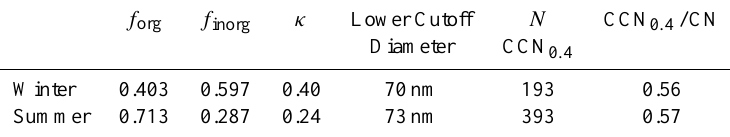
Table 5. Organic and inorganic fraction derived from filter samples, calculated hygroscopicity factor, critical diameter for CCN 0 . 4 , CCN 0 . 4 number concentration, and CCN/CN ratios for winter and summer pristine air at